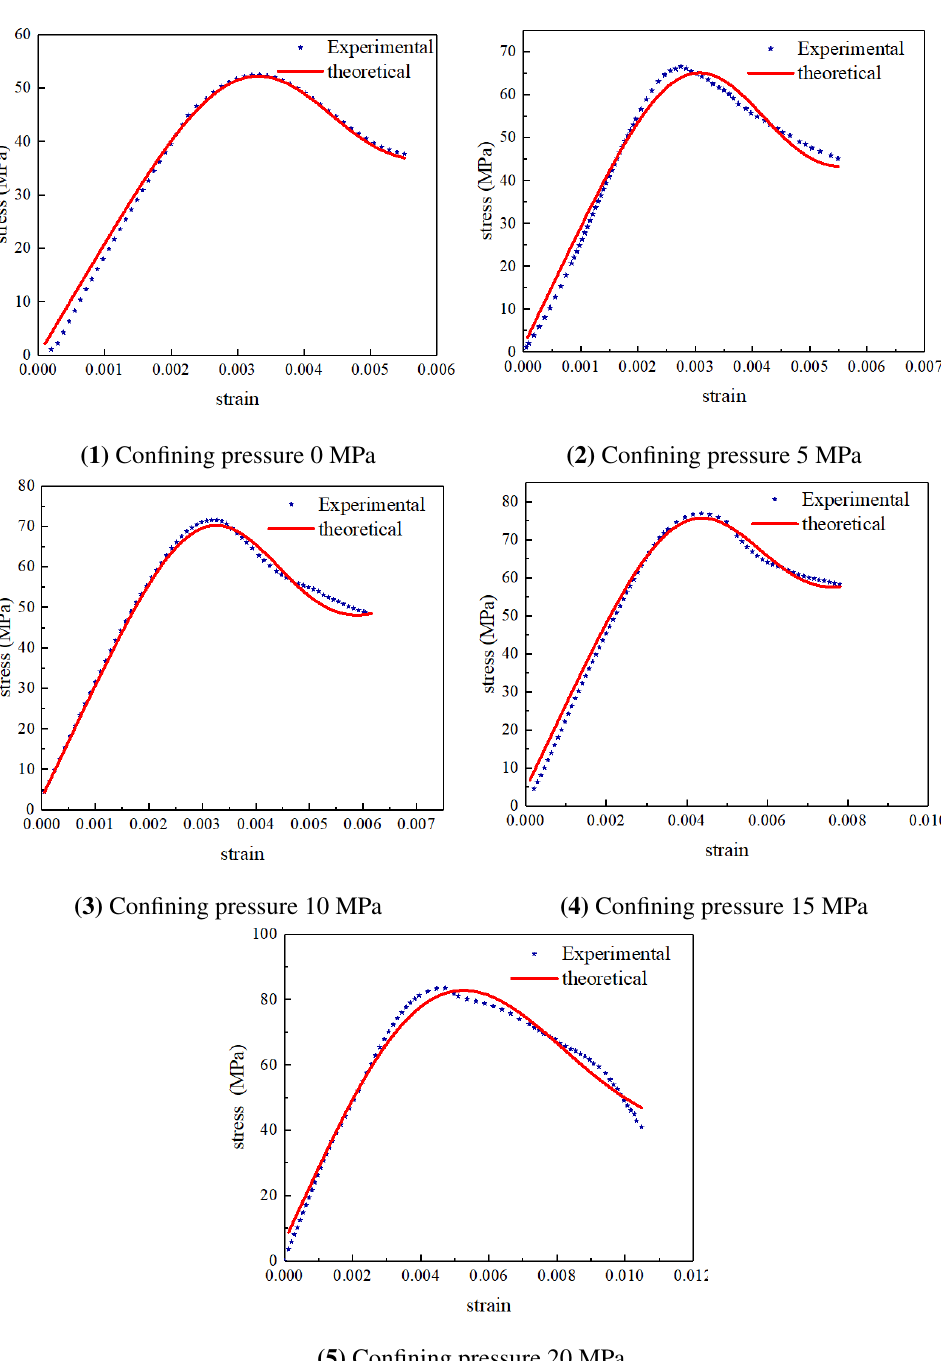
Fig. 4 Comparison of experimental curves and fitting curves under different confining